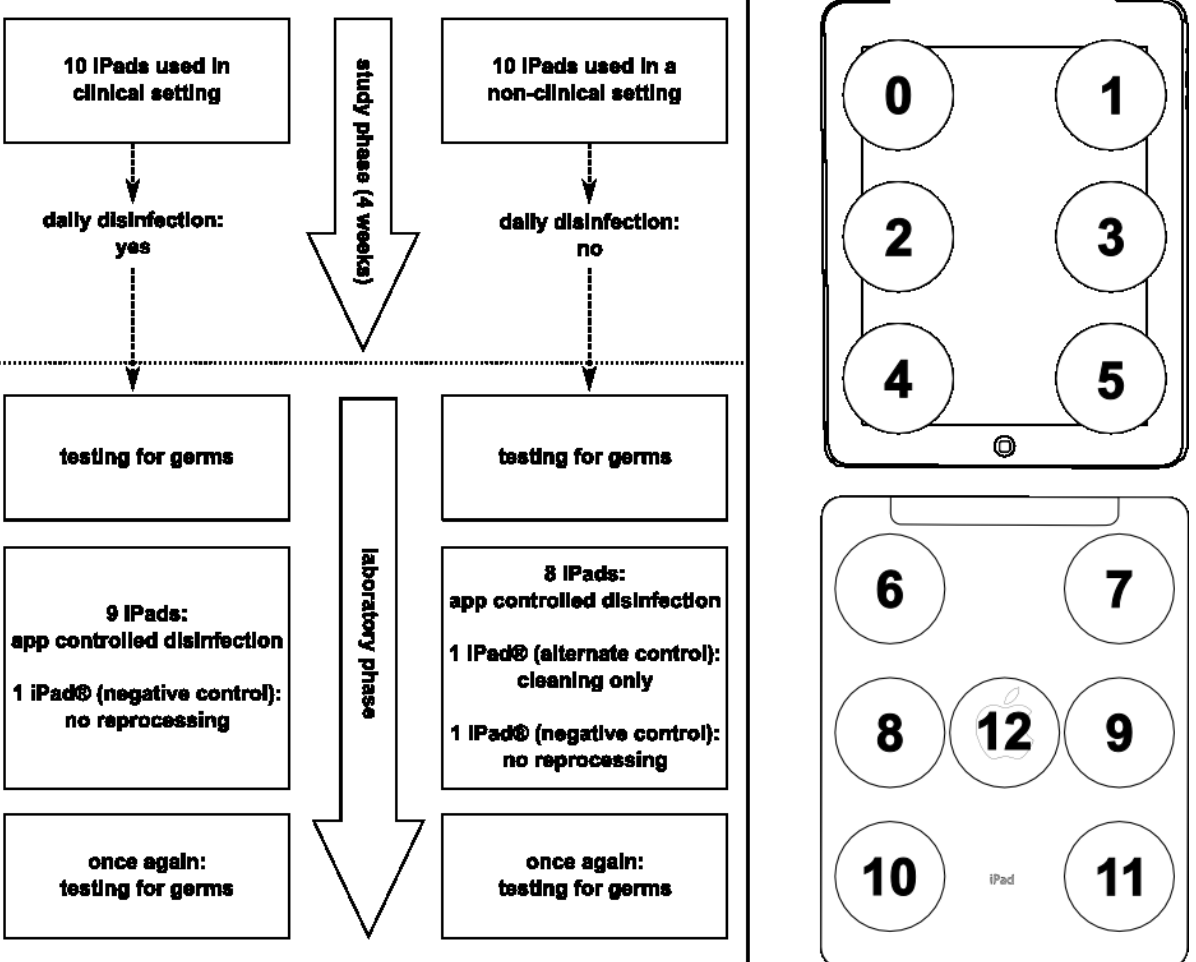
Figure 2. Flowchart on the timeline of the 2 settings of iPad usage (clinical and nonclinical) and contact points used for microbiological sampling of an iPad (surface material was glass on the front side [points 1-6], aluminium [points 7-12], and plastic [point 13] on the